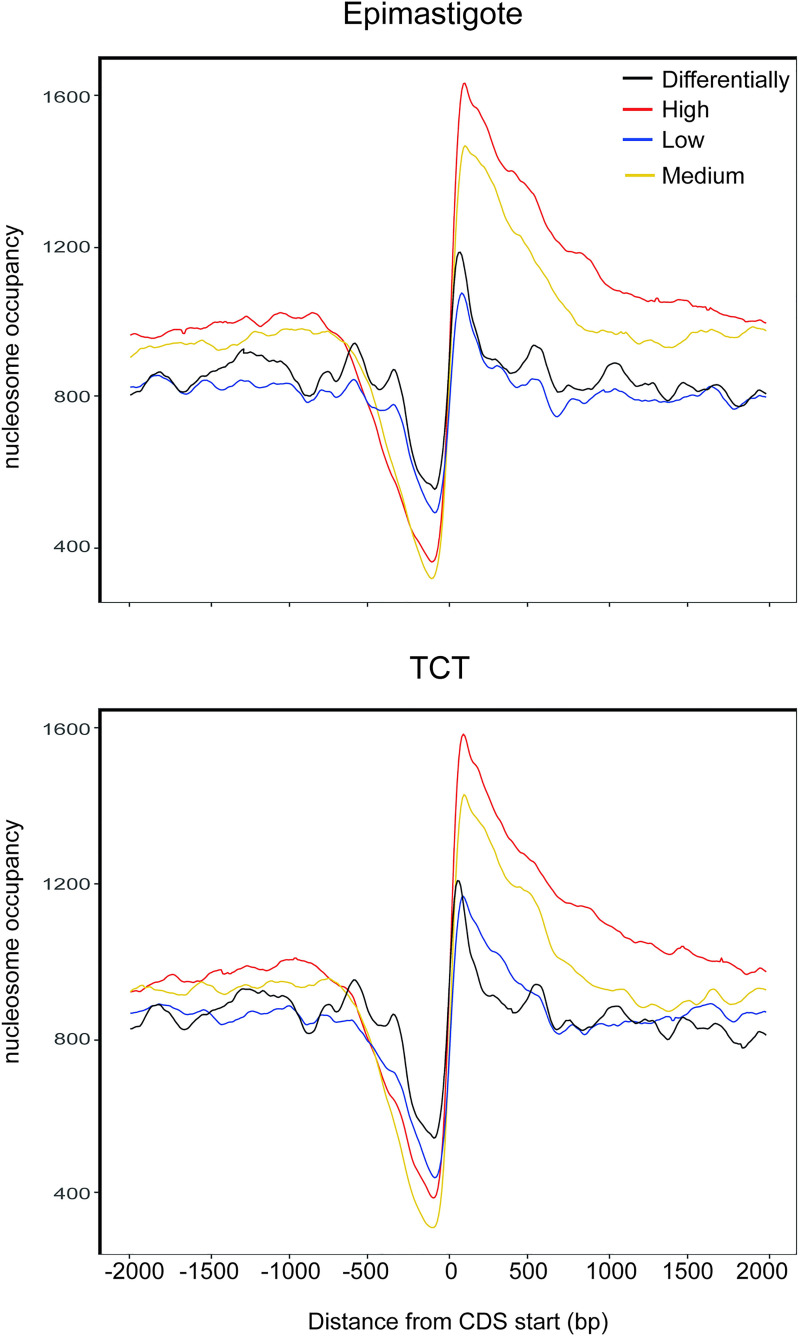
Nucleosomal occupancy according to gene expression level.High (red), medium (yellow), low (blue) and differentially expressed (black) genes for epimastigotes (top) and TCTs (below). The first ATG from each CDS is shown as 0 on the x axis. The number of CDSs used in this analysis was as follows: for epimastigotes (high, 3485; medium, 3484; low, 3353; differential, 1872) and for TCTs (high, 3486; medium, 3484; low, 3352; differential, 1663).